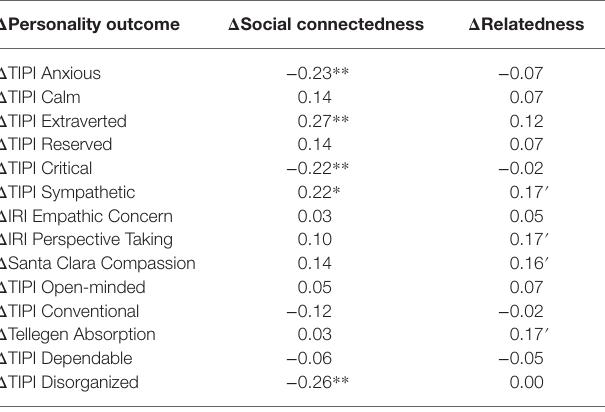
TABLE 6 | Examining covariation over time (baseline—four weeks) between personality and social connectedness outcomes using correlations between change